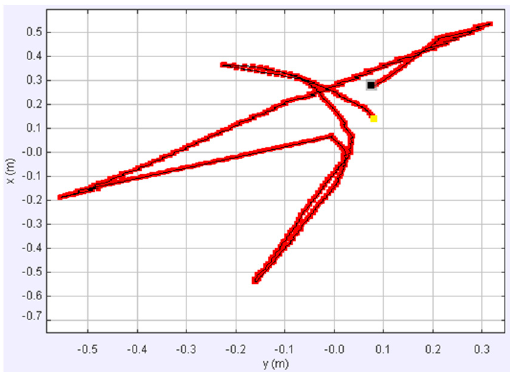
Figure 18. The path in Figure 17 shown by Tracker.